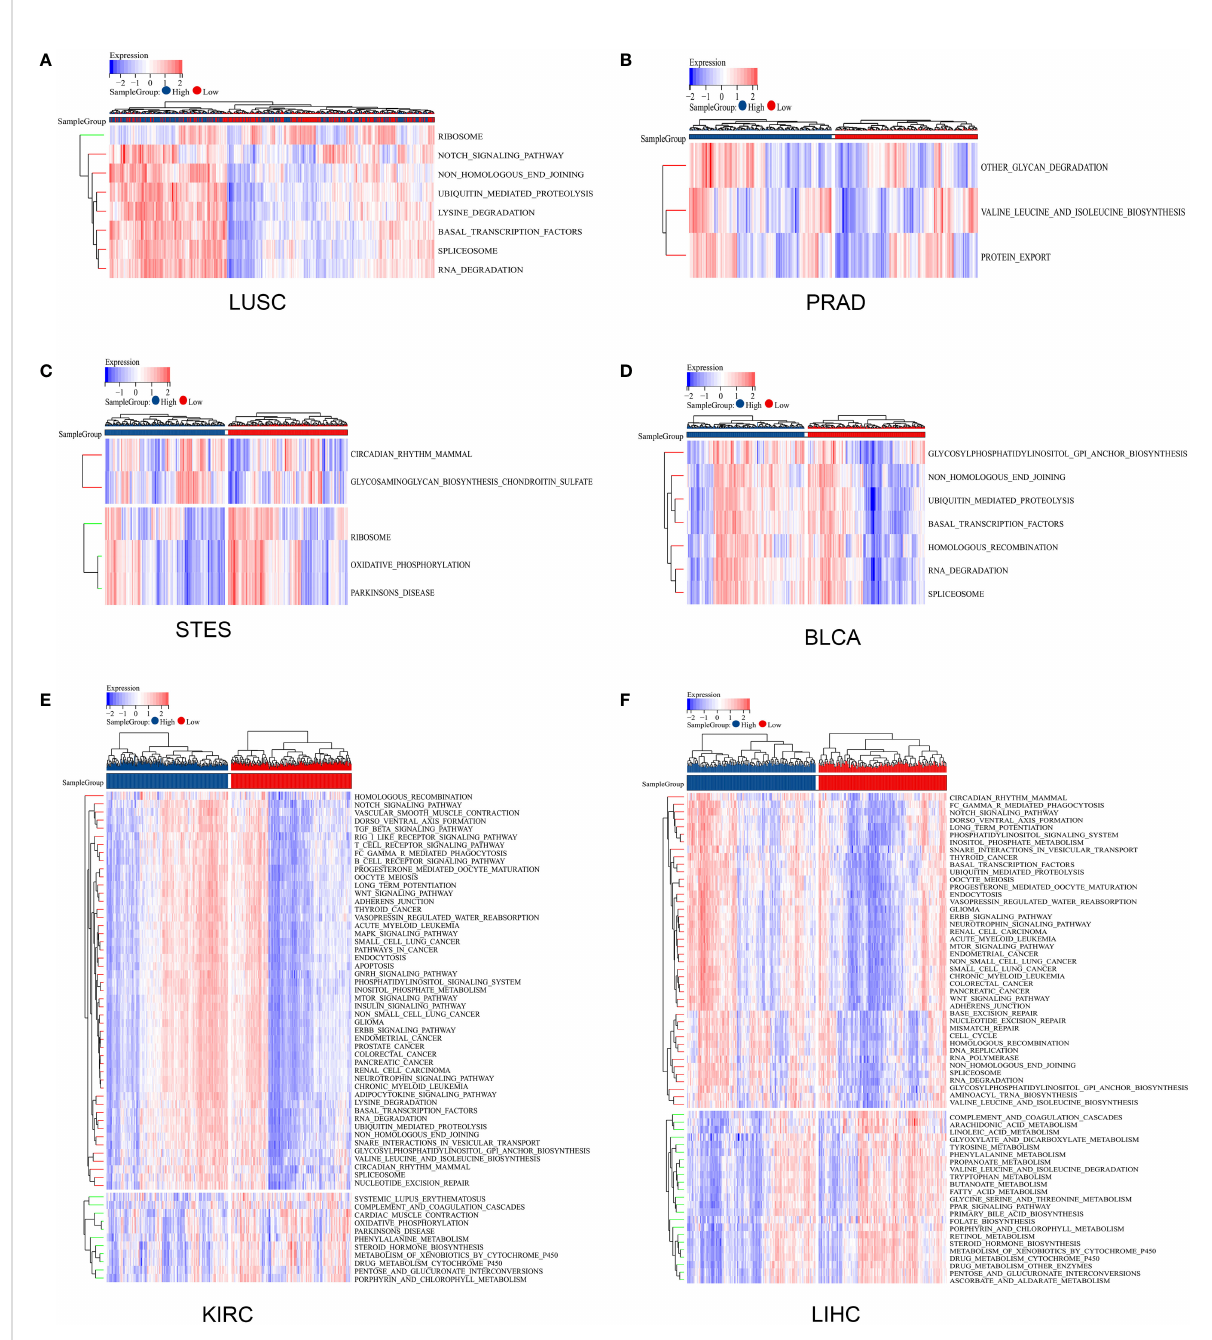
FIGURE 7 Pathway analysis using gene set variation analysis. (A) pathway analysis of ZNF419 in LUSC; (B) pathway analysis of ZNF419 in PRAD; (C) pathway analysis of ZNF419 in STES; (D) pathway analysis of ZNF419 in BLCA; (E) pathway analysis of ZNF419 in KIRC; (F) pathway analysis of ZNF419 in LIHC. LUSC, lung squamous cell carcinoma; PRAD, prostate adenocarcinoma; STES, stomach and esophageal carcinoma; BLCA, bladder urothelial carcinoma; KIRC, kidney renal clear cell carcinoma; LIHC, liver hepatocellular